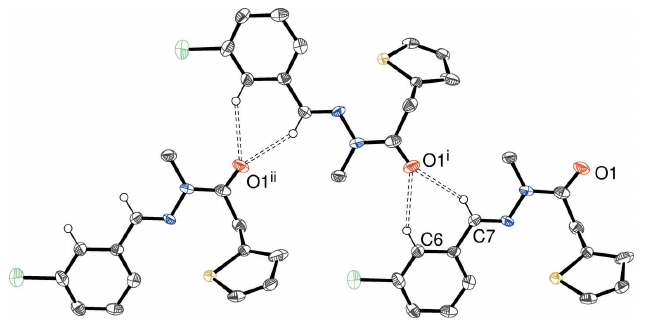
Figure 6 Fragment of an [010] hydrogen-bonded chain in the crystal of (III).